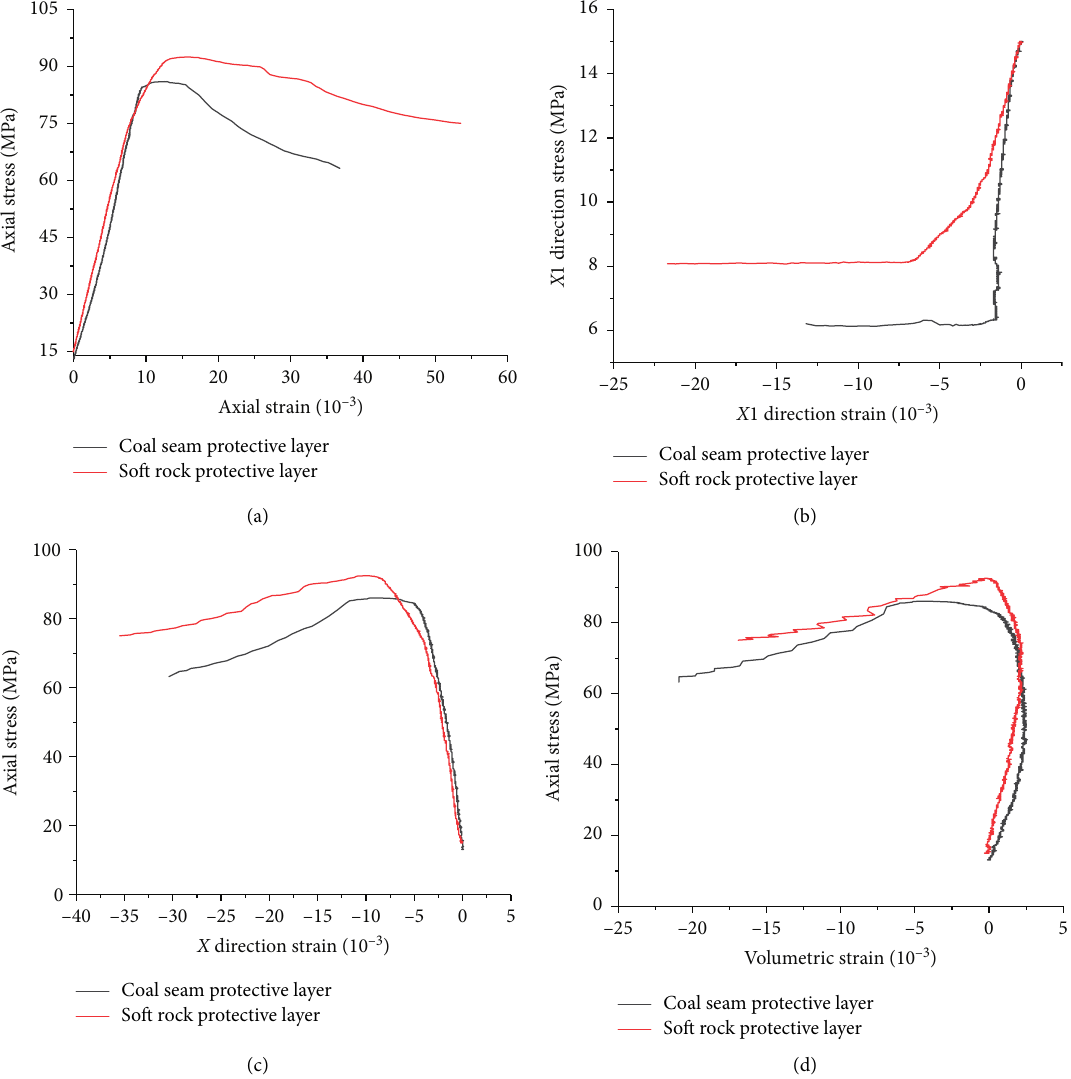
Figure 12: Comparison of mechanical differences under different protective layer mining modes. (a) Axial strain. (b) X 1 direction strain. (c) X direction strain. (d) Volumetric